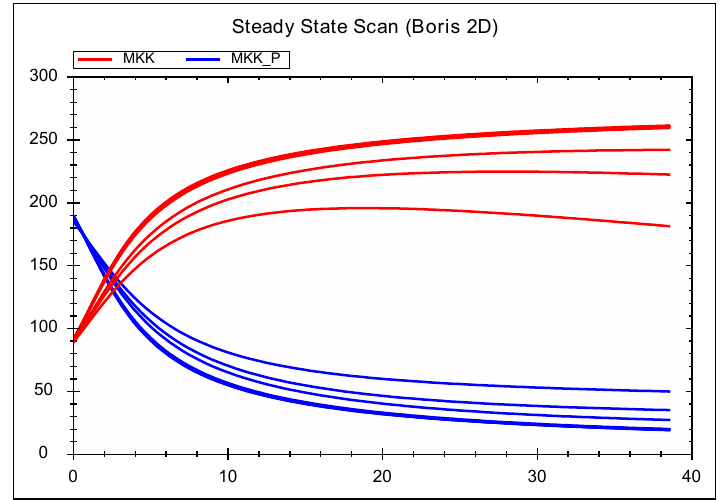
Figure C.8: The simulation result gained from the simulation description given in Listing